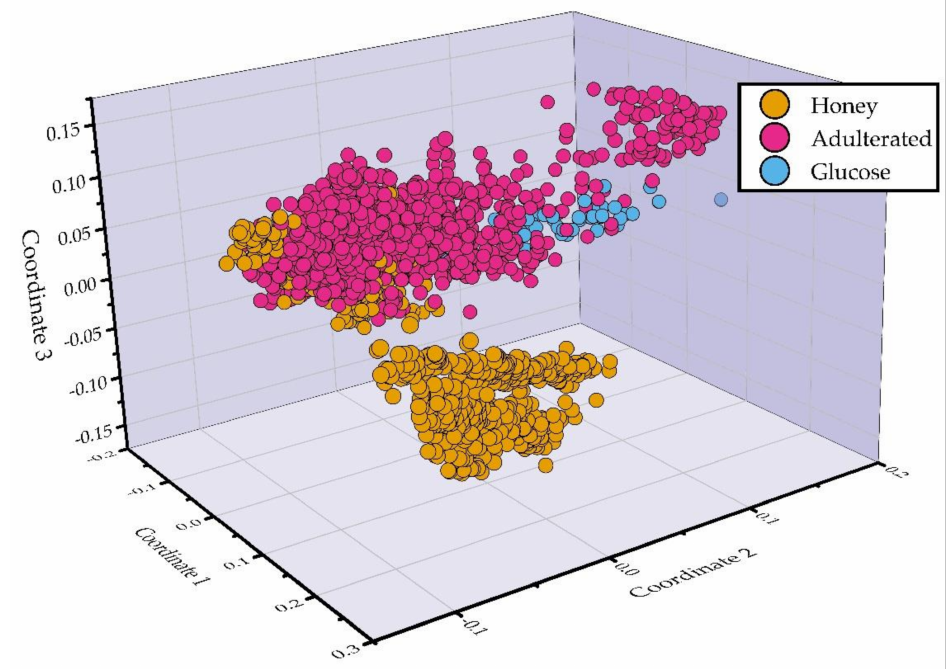
Figure 2. Multidimensional scaling (MDS) of the LIBS